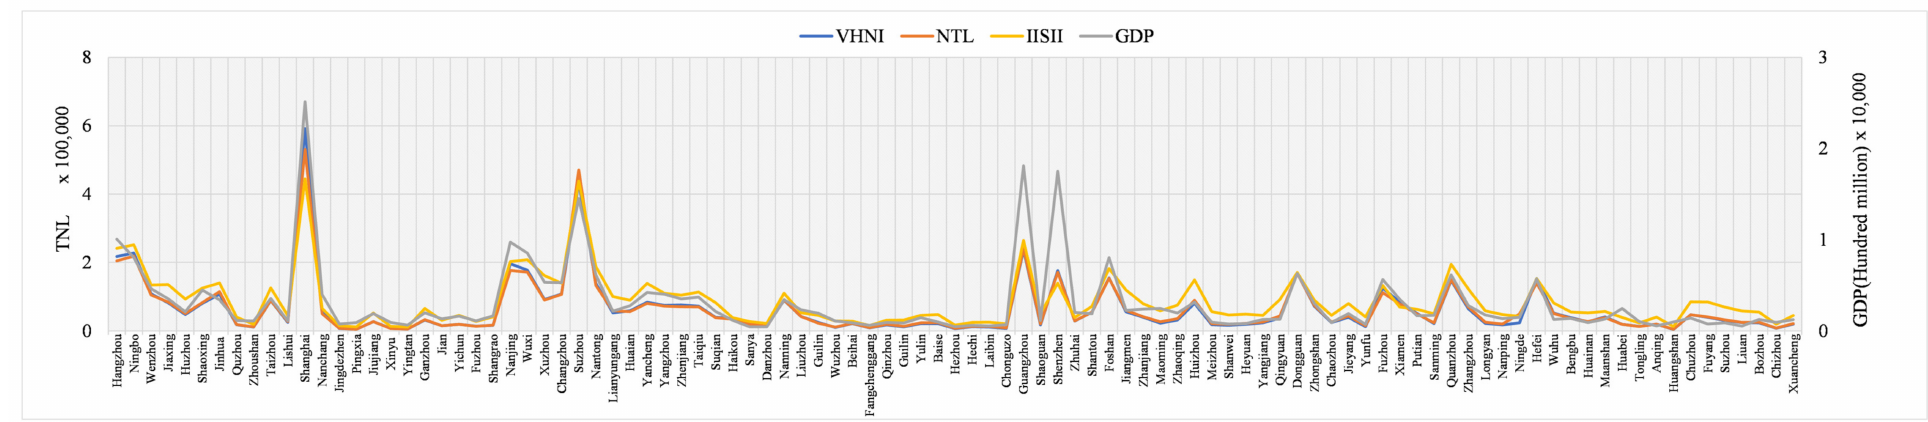
Figure 3. TNL and GDP municipal scale of different indices.